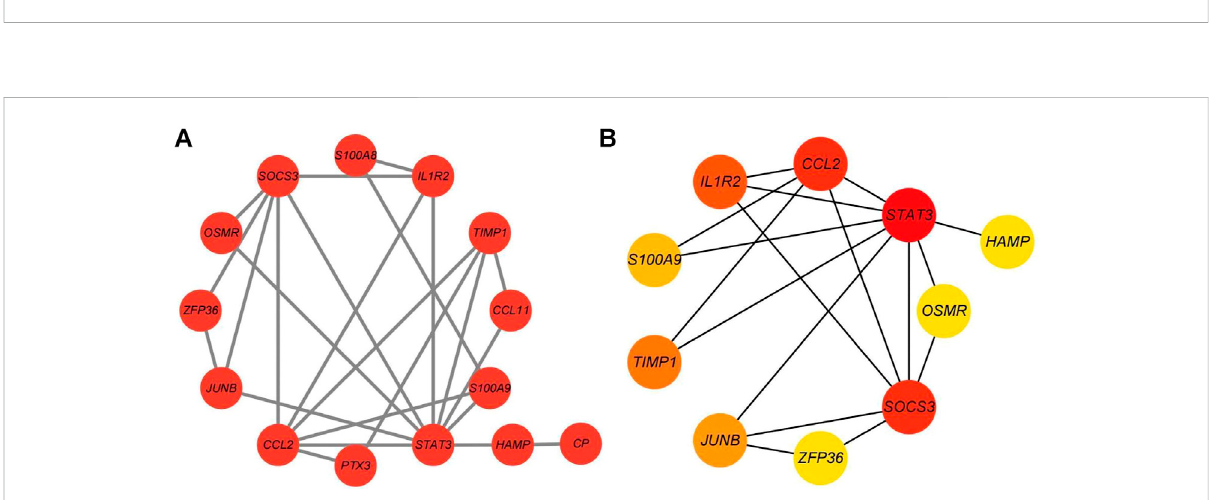
FIGURE 4 PPInetworkofDEGsconstructedusingCytoscape. (A) PPInetworkcontaining23nodesand24edgesconstructedbasedontheSTRINGonline database and visualized using Cytoscape. (B) The most signi fi cant genes obtained from the PPI